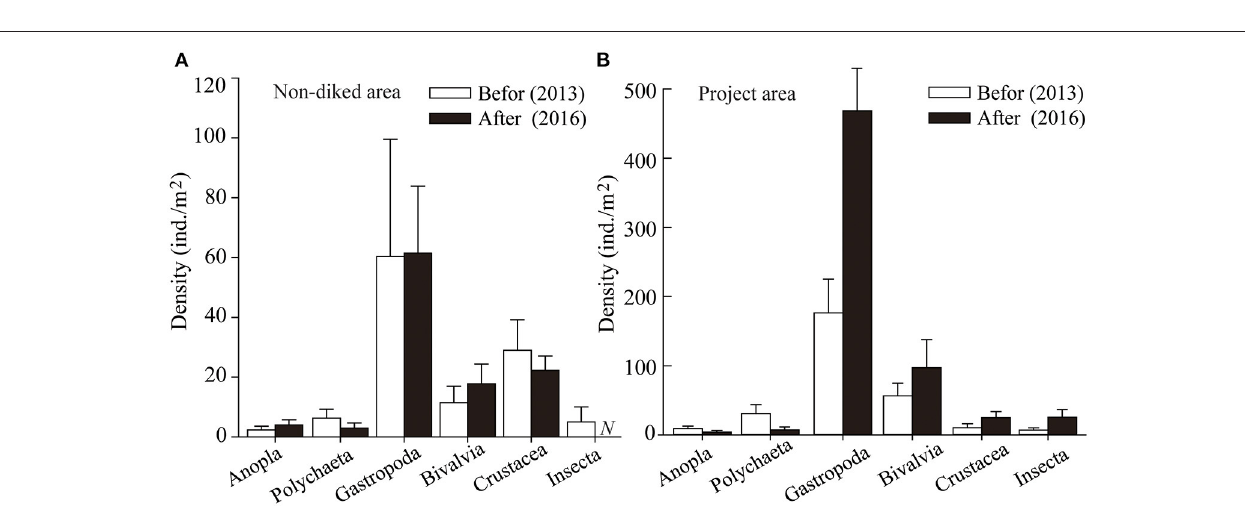
FIGURE 5 | Density change in different macrobenthic groups before and after the diking project in non-diked (A) and project (B) areas in the Chongming Dongtan salt marsh, Yangtze Estuary, China. Error bars indicate the SE of the mean. There were no significant differences before and after the diking project in each group ( t -test, P <